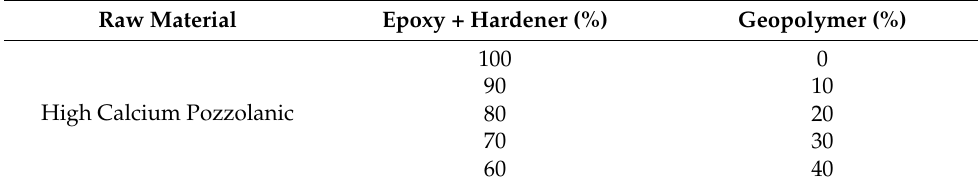
Table 1. Epoxy geopolymer resin formulation design.